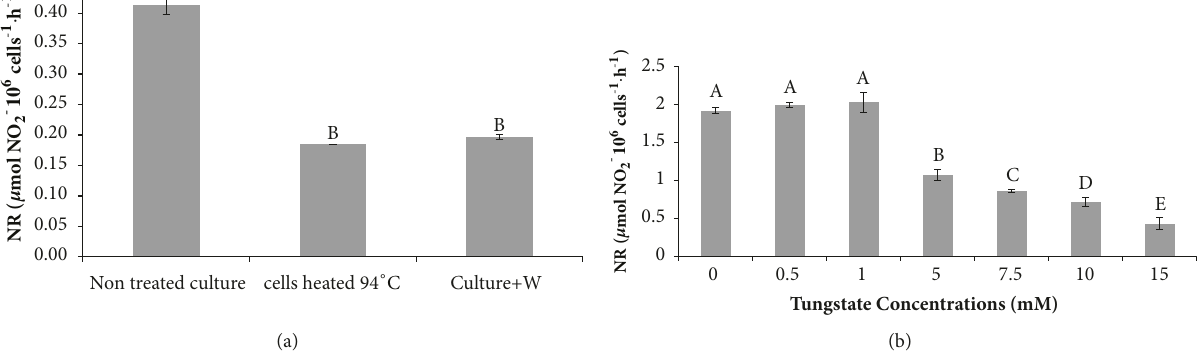
Figure 2: Impact of tungstate on NR activity (a) NR activity measurement in D. tertiolecta cells under different conditions: nontreated cells, heated cells (94 ∘ C), and cells treated with sodium tungstate after 15 days of culture at F/2. (b) Effect of concentration of sodium tungstate on NR activity in D. tertiolecta cells. Tested concentrations: 0, 0.5, 1. 5, 7.5, 10, and 15 mM. Statistical analysis was made using least significant difference (LSD) in